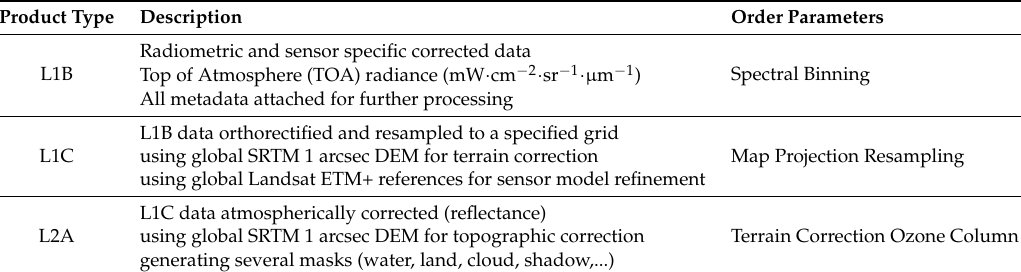
Table 1. DESIS products and user selectable processing